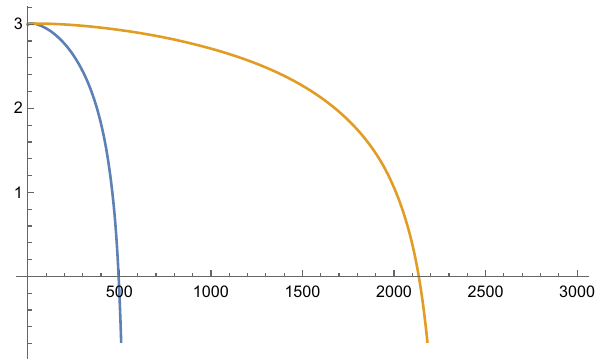
Fig. 11 Free energy in terms of temperature with G = m = k = 1, and λ = 1 / 6. The blue line corresponds to N = 10 and the brown one to N = 15